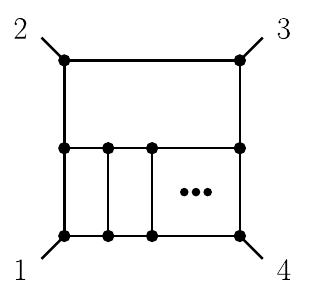
Figure 1 . A subclass of diagrams which contribute to the cuts considered in this